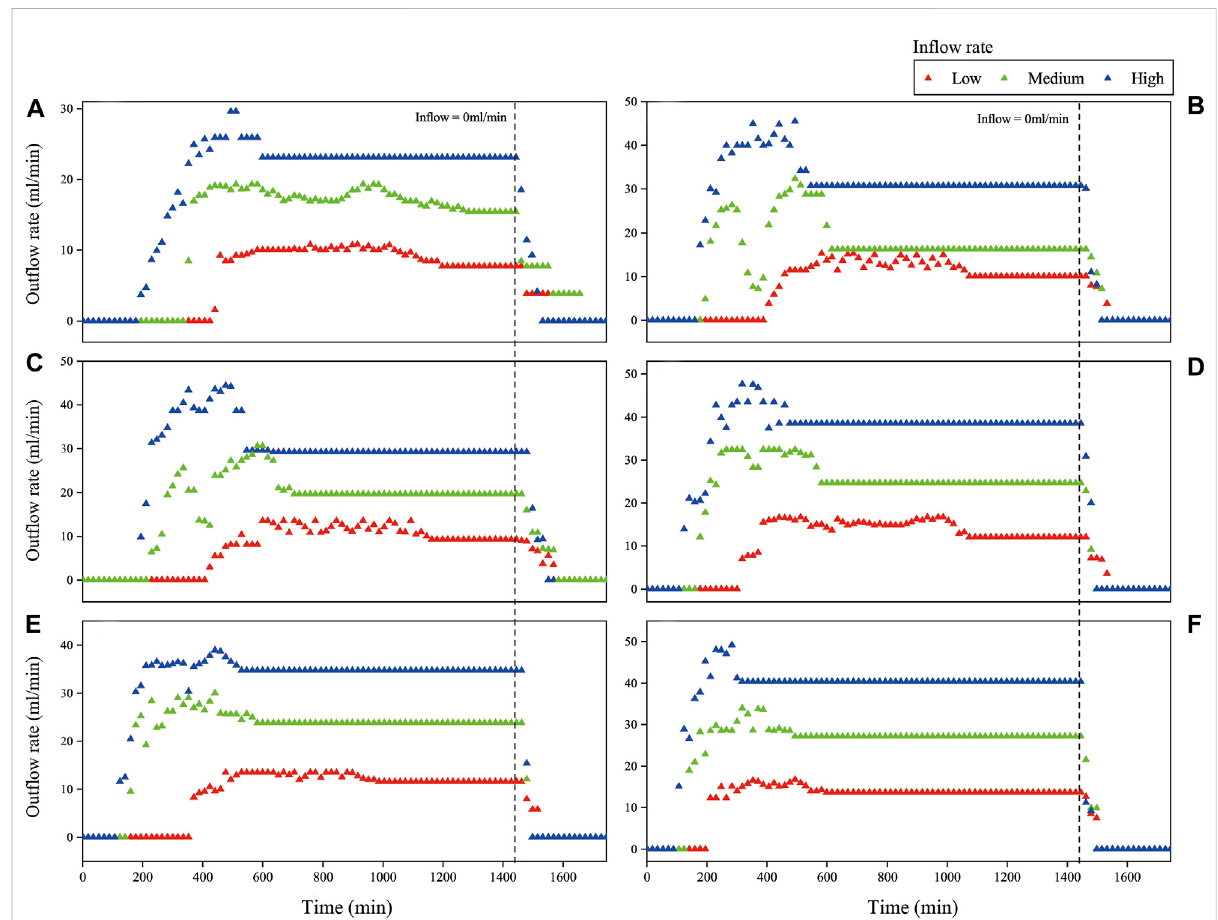
FIGURE 3 Out fl ow rate variation over time of different media under different in fl ow rate (A) 25% Z+75% S, (B) 50% Z+50% S, (C) 25% ZHD10 + 75% S, (D) 50% ZHD10 + 50% S, (E) 25% ZHD50 + 75% S, and (F) 50% ZHD50 + 50%